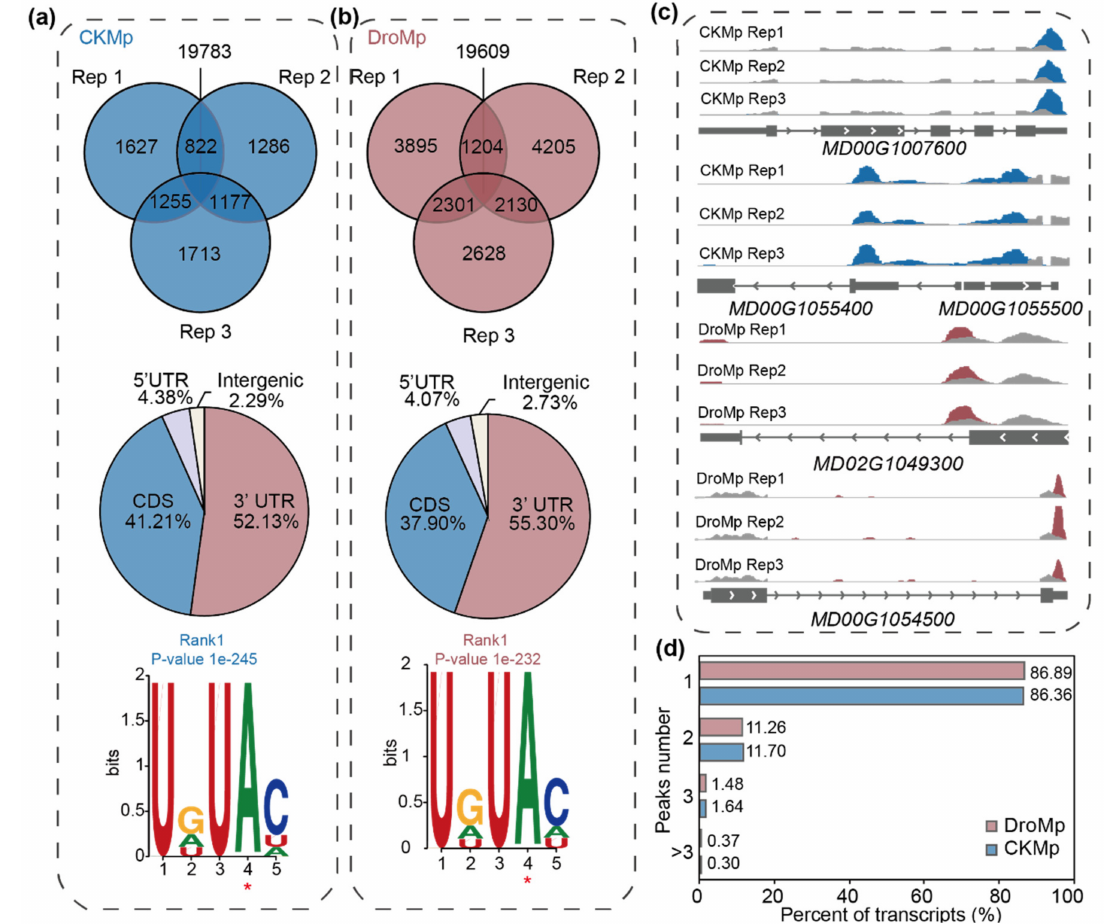
Figure 1. Transcriptome-wide m 6 A methylome in Malus prunifolia seedlings in response to drought. ( a , b ) Venn diagrams demonstrating the overlap of m 6 A peaks from three replicates ( top ), the enriched motif ( bottom ), and m 6 A peak distribution along transcripts ( middle ) under control ( a ) or drought conditions ( b ). The asterisks in the two motifs marked the positions that are modified. CDS, coding sequence; UTR, untranslated region; DroMp, M. prunifolia seedlings were treated with drought stress; CKMp, M. prunifolia seedlings were grown under control conditions. ( c ) Integrative Genomics Viewer (IGV) tracks. ( d ) Percentage of m 6 A-containing transcripts with m 6 A peaks in DroMp and